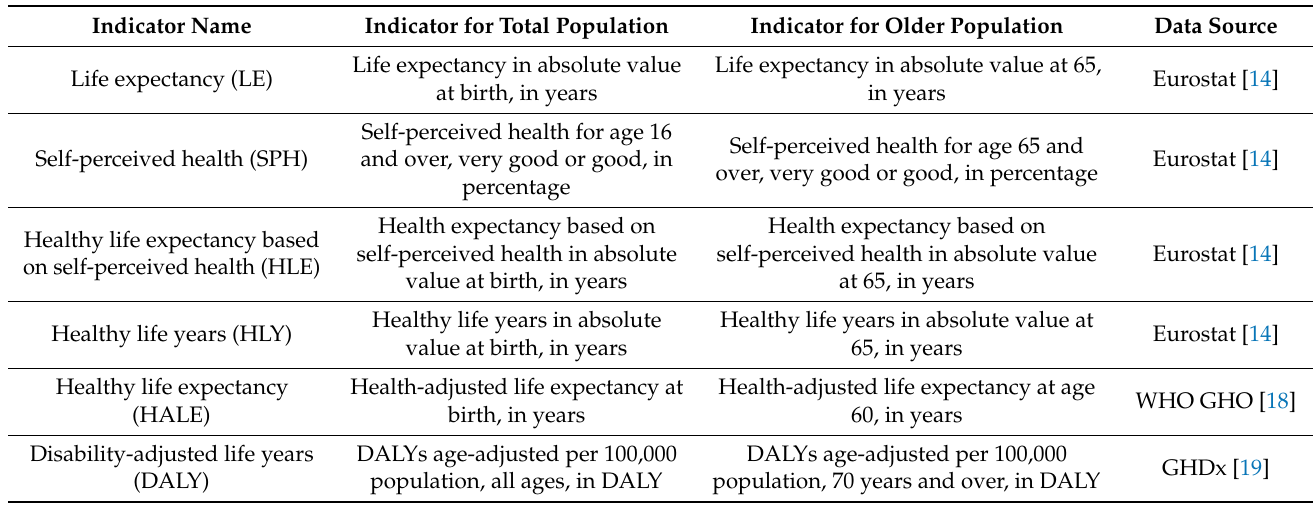
Table 1. Indicators chosen for the